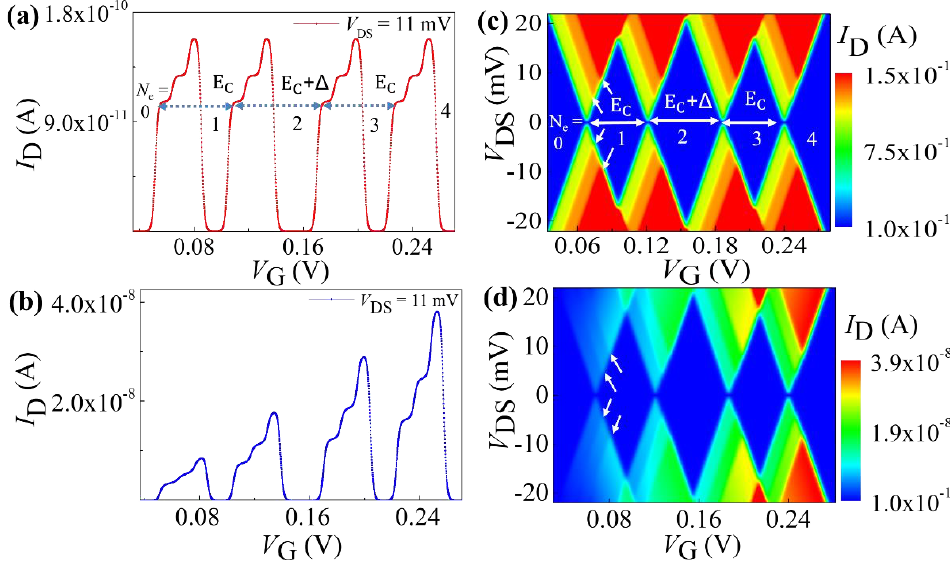
Figure 5. ( a , b ) Simulated I D − V G characteristics with three energy levels within the bias window for infinite- and variable-height barrier devices, respectively. ( c , d ) Simulated stability diagram for the same device configurations. Arrows indicate the onset of transport through a new energy level.